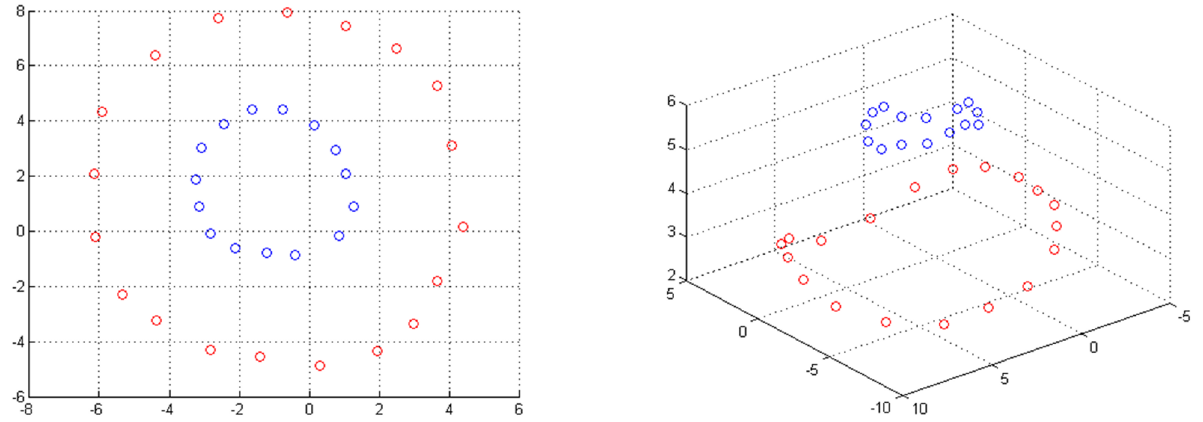
Figure 2. The non-separable two-class scenario in the input space( left ) and the two-dimensional data space in a three-feature space after the projection ( right ). The two classes are represented by the different colors: blue and red.